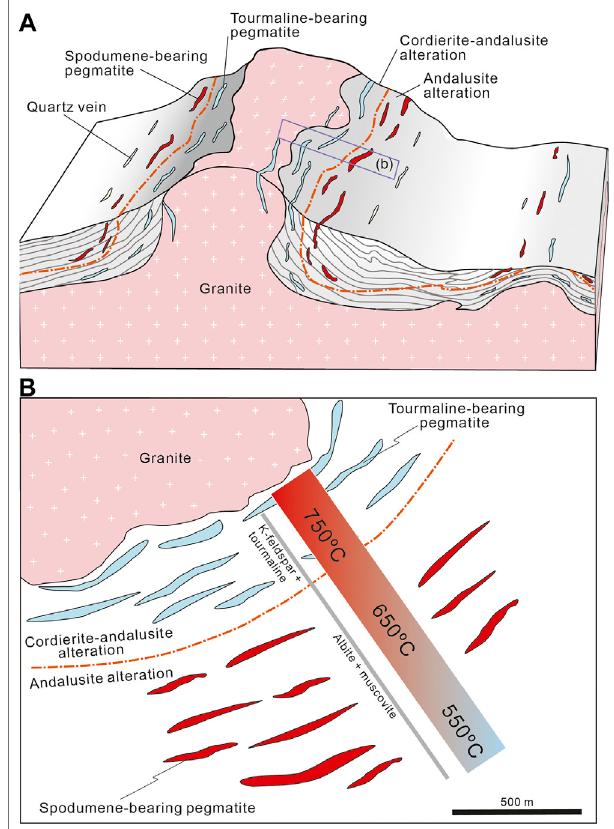
FIGURE 9 | Model of the pegmatites in the Dahongliutan area showing: (A) cross-section of the pegmatite zonation; and (B) plan view of the pegmatite zonation (modi fi ed after London, 2008). The temperatures are based on London (2008) and unpublished studies in the region of primary fl uid inclusions in spodumene, tourmaline and quartz in the pegmatites (Gao, Y.B., written communication, 2020).